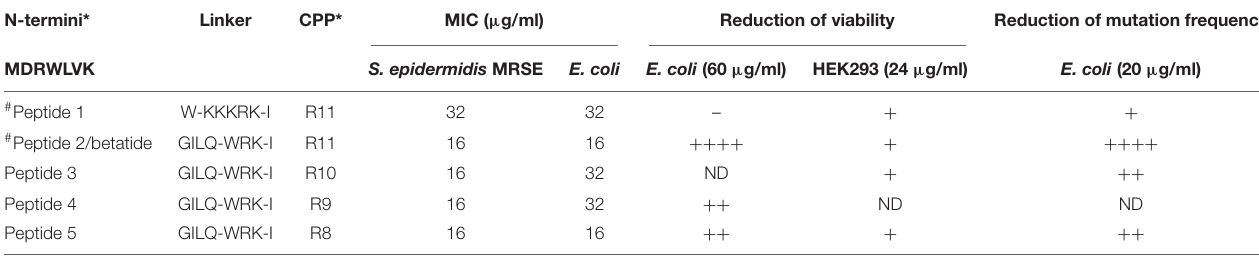
TABLE 2 | Properties of APIM-peptide